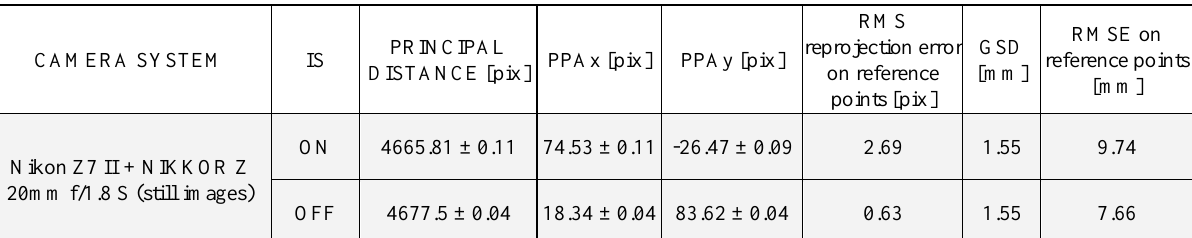
Table 2 . Results of the calibration tests in laboratory.